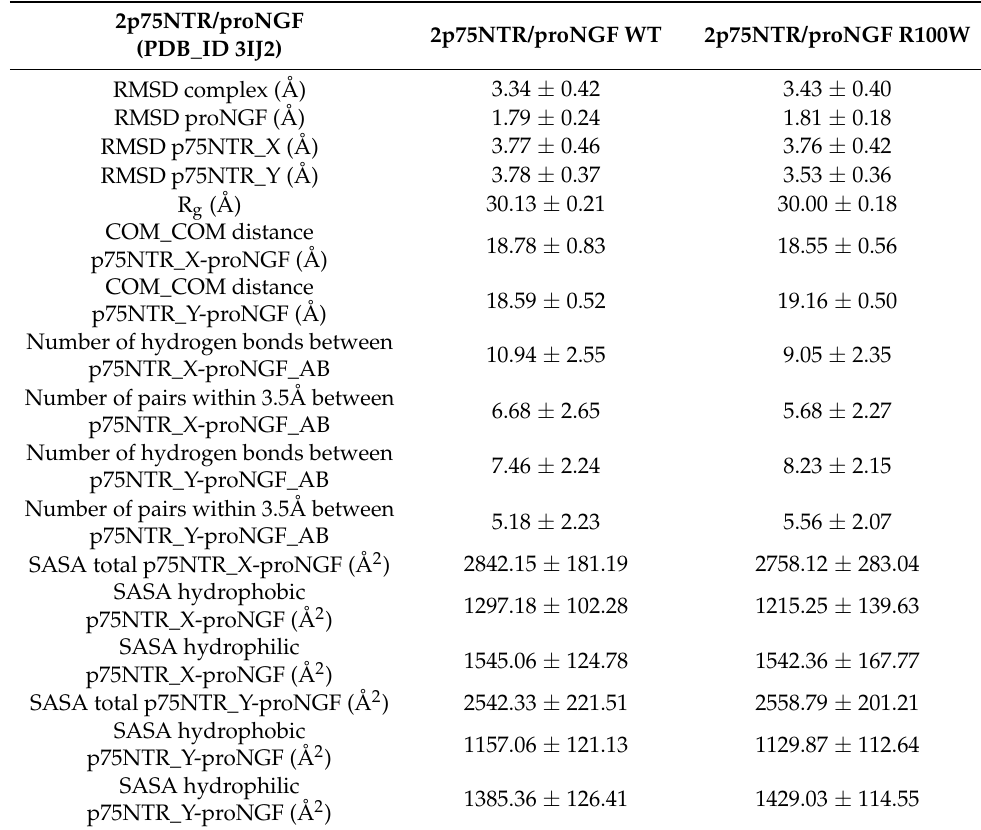
Table 2. Summary of the main structural parameters of the 2p75NTR/proNGF complex after the emergence of the R100W mutation over the 100 ns simulation frame.